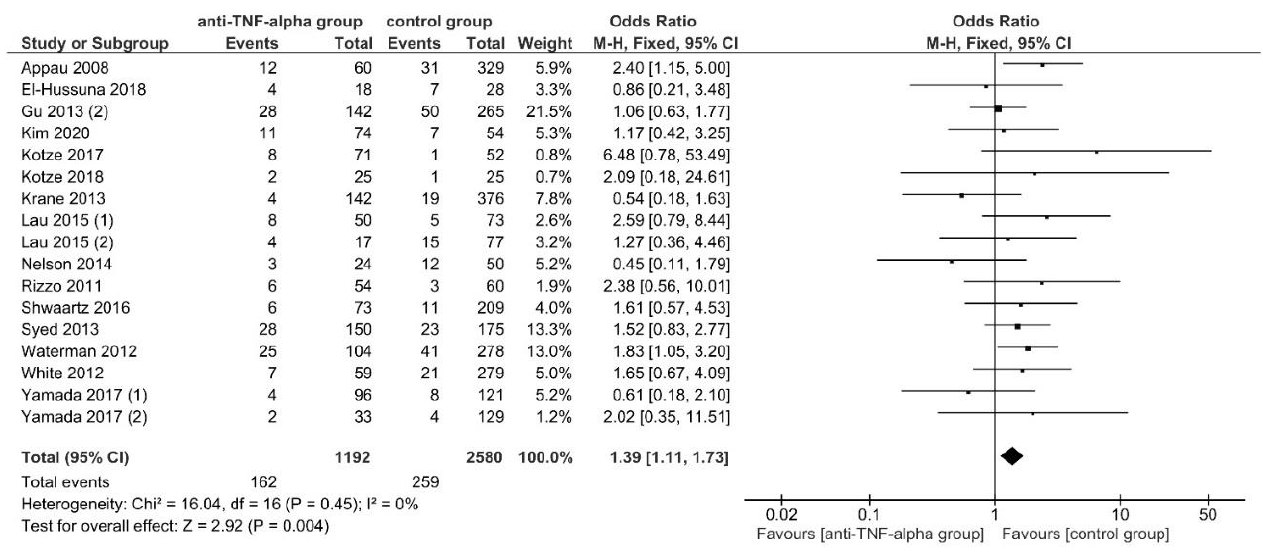
Figure 3. The fixed-effects model meta-analysis for 30-day postoperative readmission in the anti- TNF- α (intervention) and control group. Forest plot of all studies included. [21,46,52,55,59–62,71,75,78,79,87 – 89]